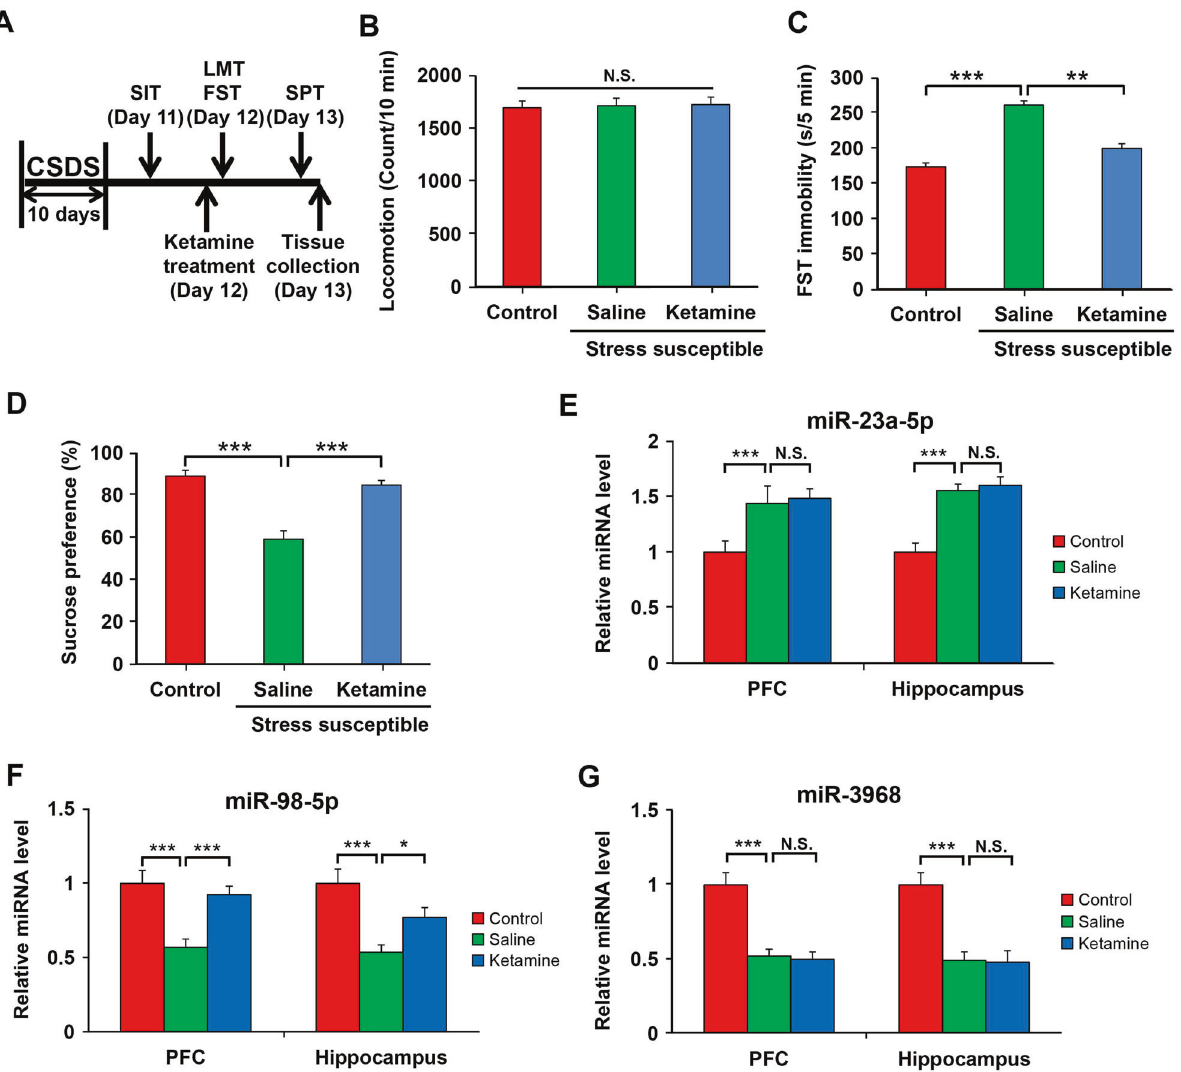
Fig. 4 Effects of ketamine on miR-23a-5p/-98-5p/-3968 expression in the PFC and hippocampus of CSDS-susceptible mice. a The schedule of ketamine administration and behavioral tests after CSDS. b – d The number of squares crossed during LMT, immobility time during FST, and sucrose-preference ratio during SPT. LMT, FST, and SPT were performed to analyze the depression-like behaviors of CSDS-resilient and -susceptible mice after ketamine administration. e – g Relative expression levels of miR-23a-5p, miR-98-5p, and miR-3968. qPCR was performed to assay the miRNA expressions in the PFC and hippocampus of saline-administered control CSDS-resilient mice and saline- or ketamine- administered CSDS-susceptible mice. Data are shown as mean ± SEM ( n = 8). * P < 0.05, ** P < 0.01, *** P < 0.001, N.S. not signi fi